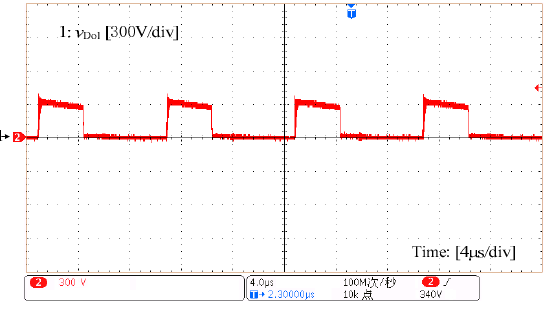
Figure 9. Waveform of v Do 1 .